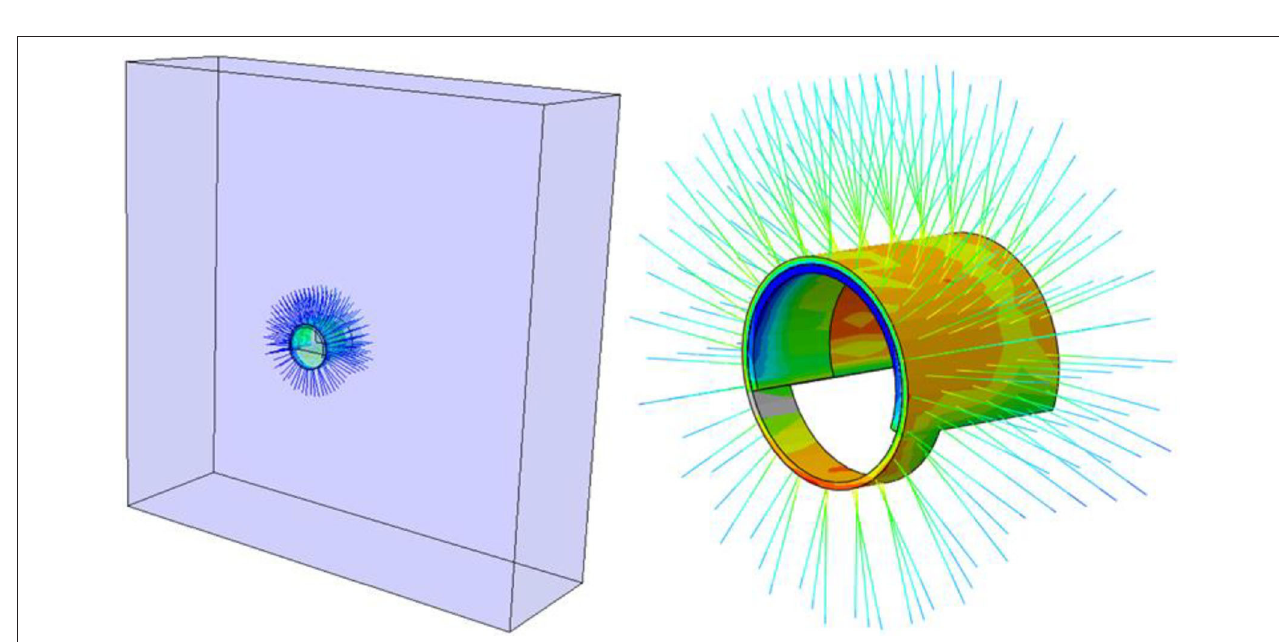
FIGURE 7 | The sixth construction step: excavation up to 15m, excavation down to 6m, and initial support down to the lining.